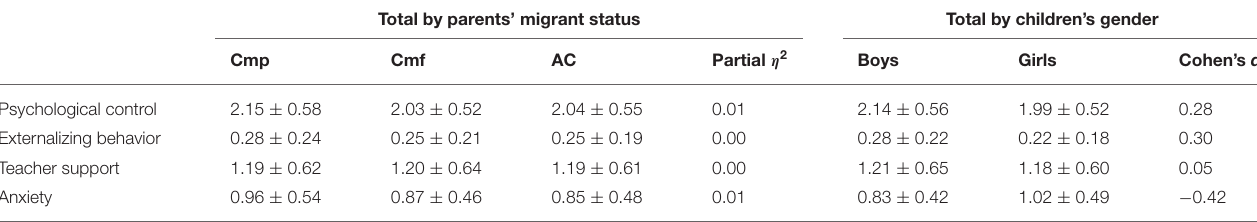
TABLE 1 | Comparisons of the key variables between parents’ migrant status groups/children’s gender groups (mean ± standard deviation).